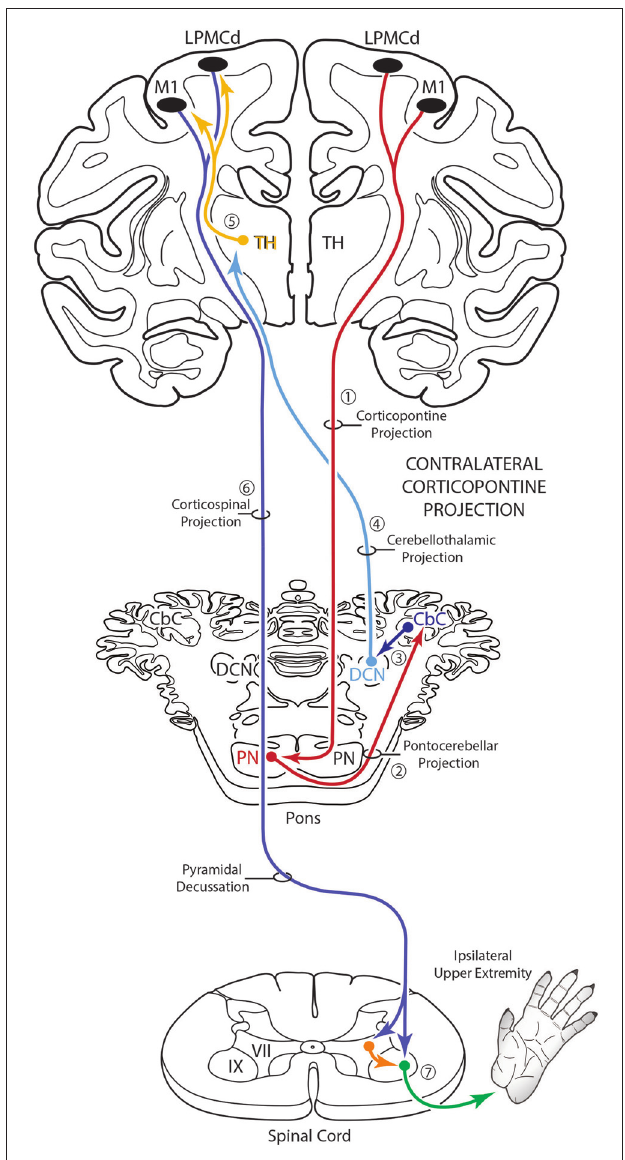
FIGURE 10 | Schematic diagram of the classical motor cerebrocebellar system with the modification of the contralateral corticopontine projection (cCPP) in the first stage (1) of the circuit. Specifically, we found M1, LPMCd and LPMCv (not illustrated) all gave rise to a cCPP (1), demonstrating that the corticopontine projection from the lateral motor region is bilateral. Considering the sequential stages of the cerebrocebellar circuit as classically reported (stages 2–7, and as illustrated in Figure 1 ), the overall effect of the cCPP would theoretically be on the ipsilateral upper extremity. Thus, the CPP may play a role in both right and left upper limb